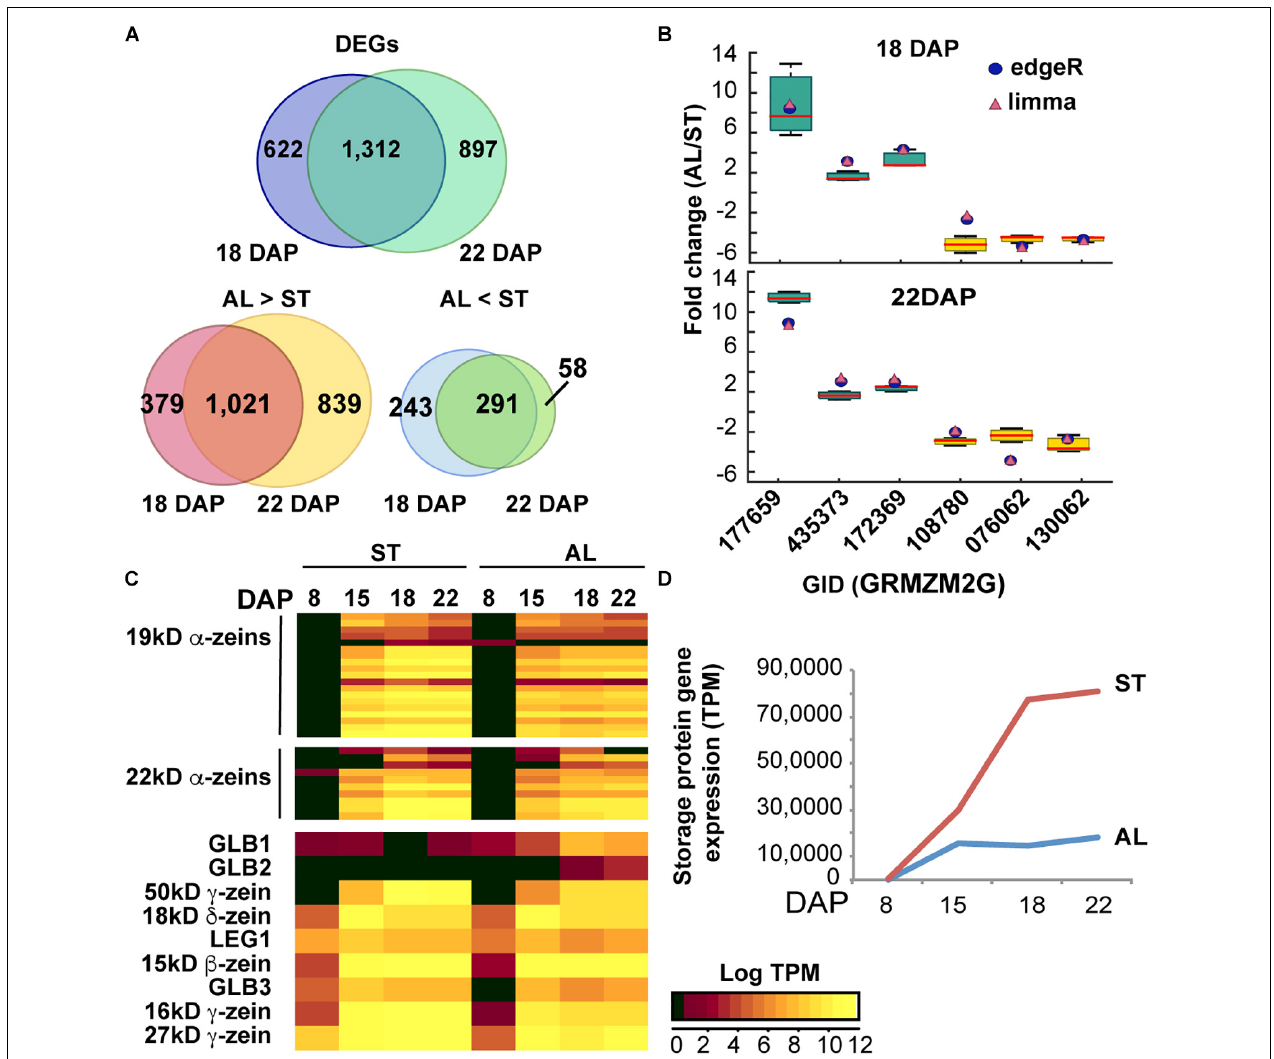
FIGURE 4 | Gene expression analysis of maize endosperm. (A) Number of protein-coding genes expressed in aleurone (AL) and starchy endosperm (ST) at 18 and 22 DAP. (B) Differentially expressed genes (DEGs) in AL vs. ST at 18 and 22 DAP based on RNA-seq analysis. The Venn diagrams show the number of DEGs shared by the two developmental stages (18 and 22 DAP) or unique to either one or the other. (C) Quantitative RT-PCR of transcripts expressed specifically in either AL or ST endosperm. Fold changes measured by RT-qPCR are shown by Whisker box plots, and fold changes calculated by edgeR and limma are shown as blue circles and pink triangles, respectively. Expression was normalized to that of UBC9. Data is from three biological replicates. (D) Heat map and hierarchical clustering analysis of expression of genes coding for prolamins (zeins) and non-prolamin storage proteins. Log-transformed TPM values of expression levels are colored according to intensities (see color scale in figure). (D) Abundance of storage protein transcripts in aleurone (AL) and starchy endosperm (ST) during